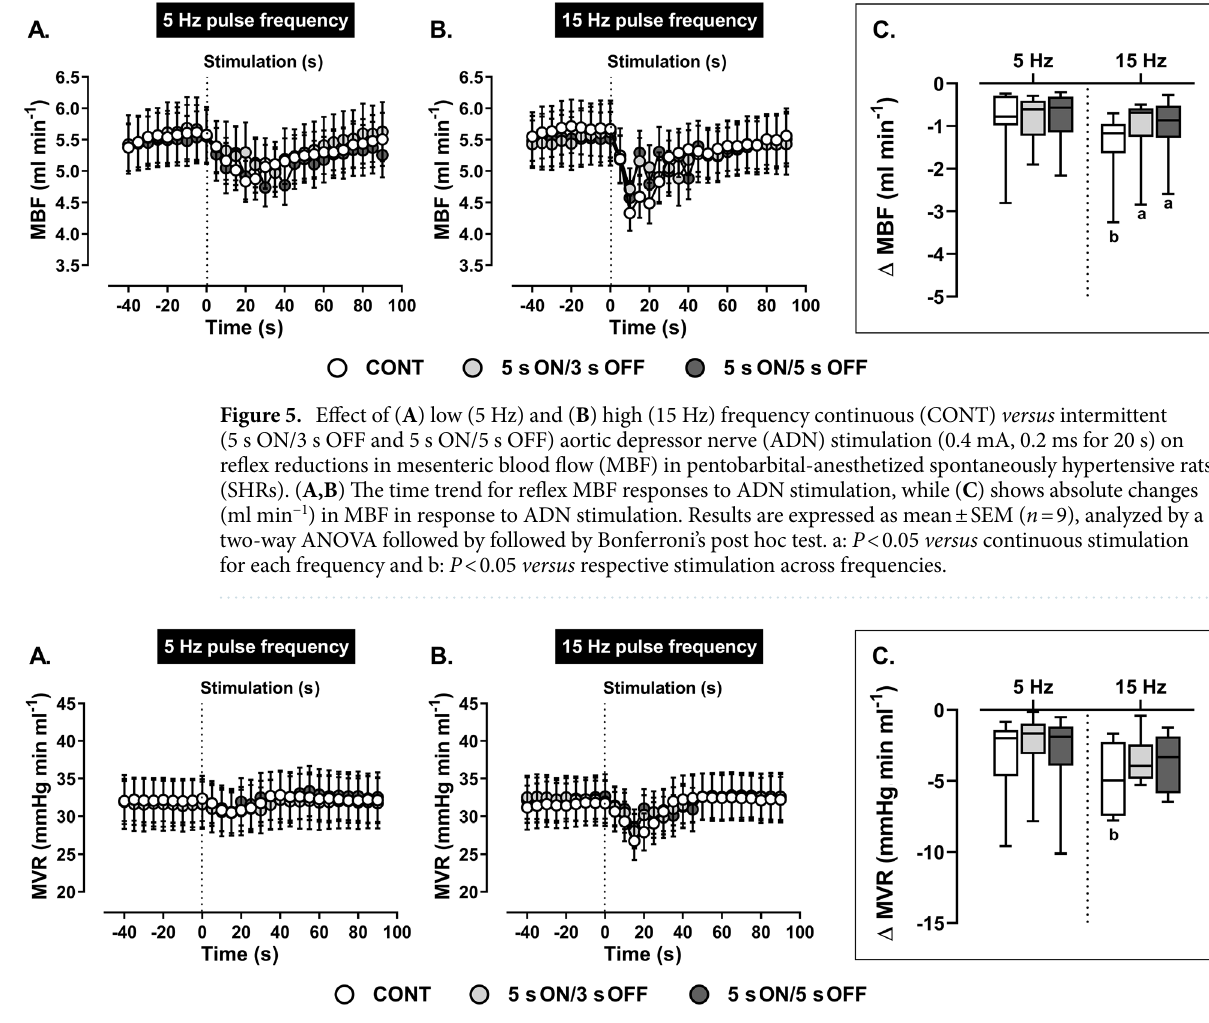
Figure 6. Effect of ( A ) low (5 Hz) and ( B ) high (15 Hz) frequency continuous (CONT) versus intermittent (5 s ON/3 s OFF and 5 s ON/5 s OFF) aortic depressor nerve (ADN) stimulation (0.4 mA, 0.2 ms for 20 s) on reflex reductions in mesenteric vascular resistance (MVR) in pentobarbital-anesthetized spontaneously hypertensive rats. ( A,B ) The time trend for the reflex MVR response to ADN stimulation, while ( C ) shows absolute changes (mmHg ml min −1 ) in MVR in response to ADN stimulation. Results are expressed as mean ± SEM ( n = 9), analyzed by a two-way ANOVA followed by followed by Bonferroni’s post hoc test. b: P < 0.05 versus respective stimulation across